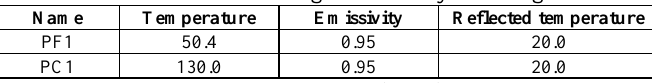
Table 4: Markers referring to the analysis of Figure 5.